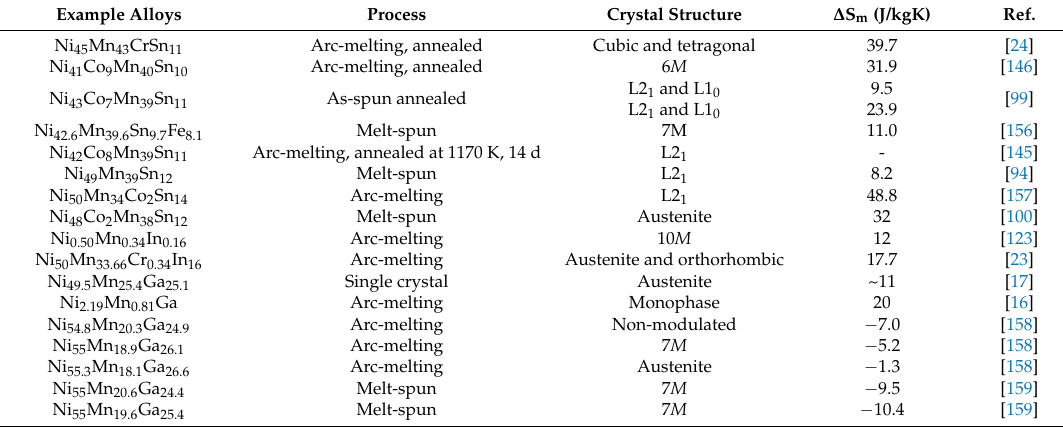
Table 2. Crystal structure and ∆ S m values in magnetocaloric (MC) alloys retrieved from literature. Example Alloys Process Crystal Structure ∆ S m